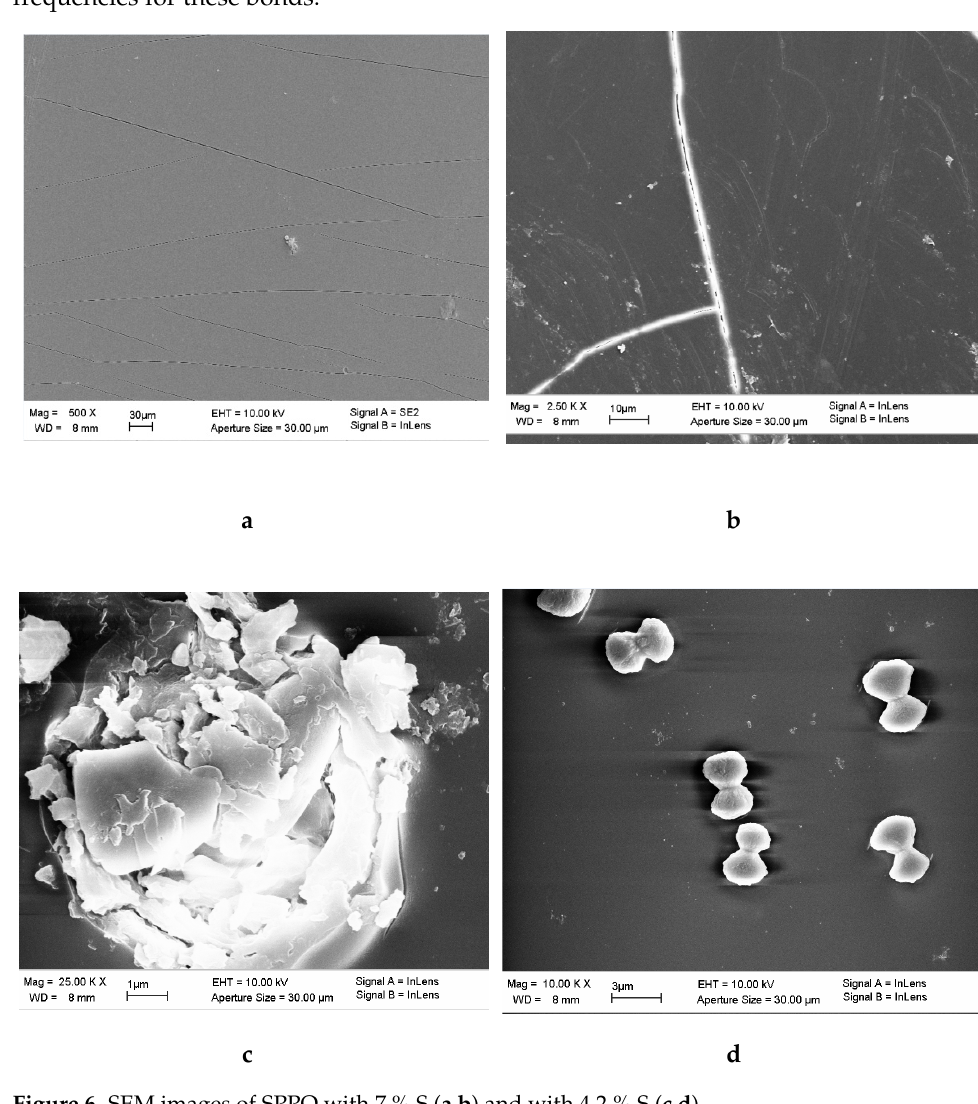
Figure 6. SEM images of SPPQ with 7 % S ( a , b ) and with 4.2 % S ( c , d ).